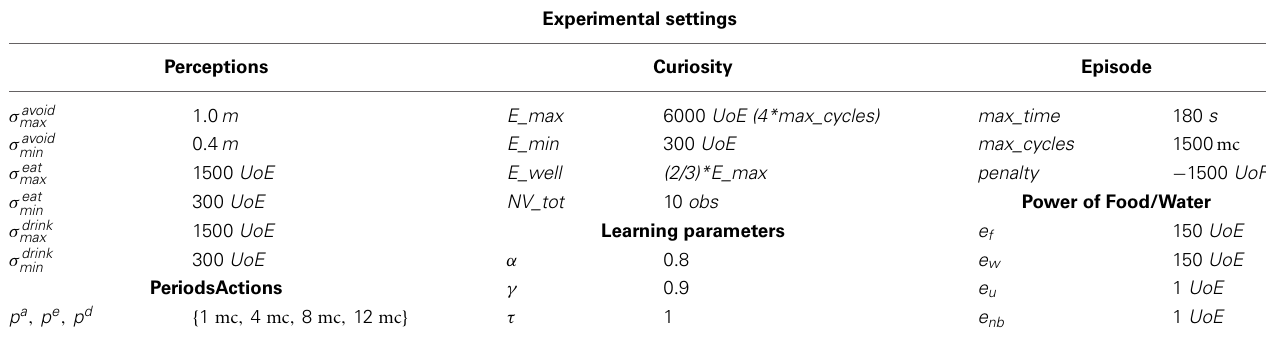
Table 4 | Table of the parameters experimental setting ( UoE , Unit of Energy; UoR , Units of Reward; mc , machine cycles; m , meters; s , seconds; obs ,